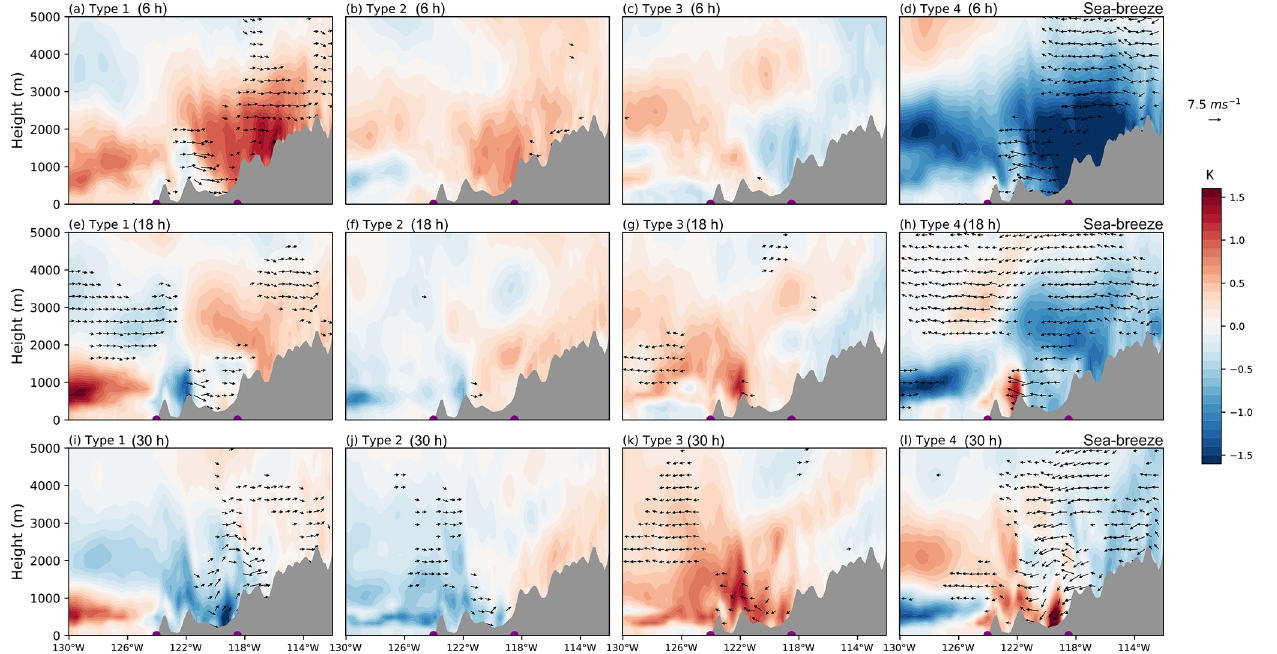
Figure 10. (a–d) 500hPa geopotential height anomaly and (e–h) surface pressure anomaly from the ensemble average for each SOM type during the sea-breeze case. The colored lines indicate forecasts at 12, 18, 24, and 30h. Dashed contours indicate negative anomaly. The shaded area in panels (e) – (h) indicates the topography. The location of the cross section (from 45 ◦ N, 130 ◦ W to 45.6 ◦ N, 112 ◦ W) in Fig. 11 is marked as the purple line in panel (g) .